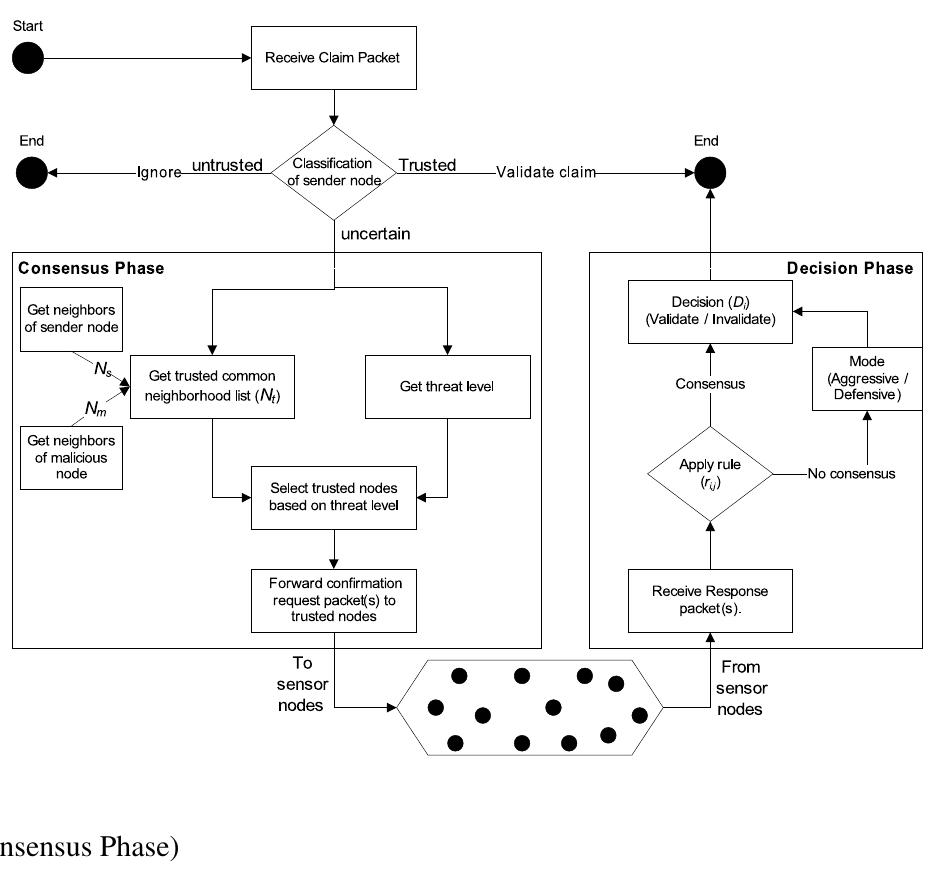
Figure 4. Intrusion-aware validation algorithm at the receiver